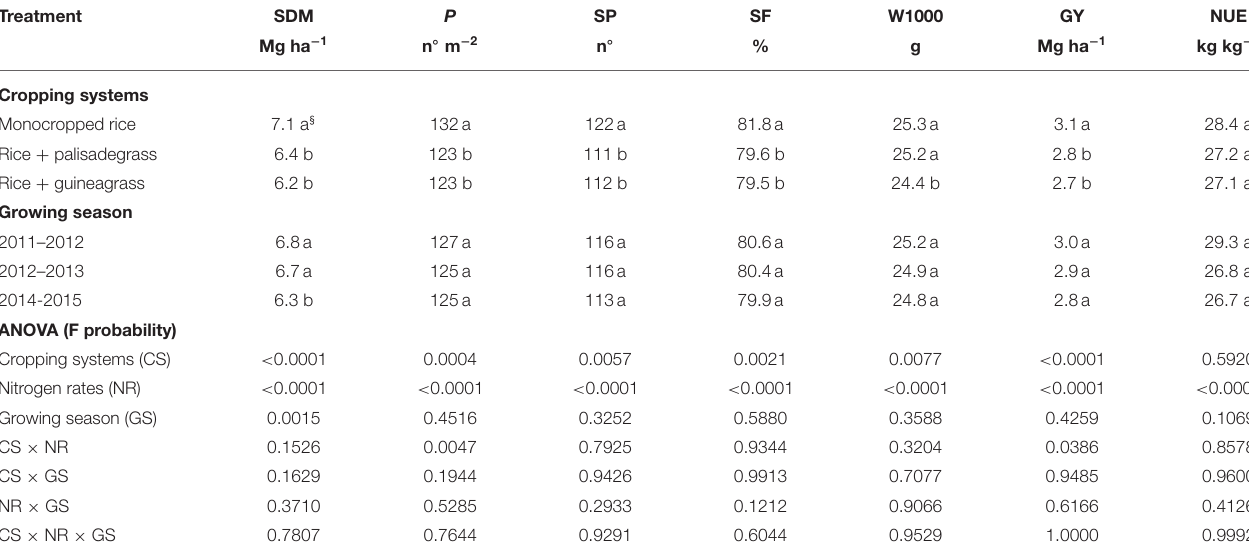
TABLE 1 | Shoot dry matter (SDM), panicles per m 2 (P), spikelets per panicle (SP), spikelet fertility (SF), 1,000-grain weight (W1000), grain yield (GY), and N-use efficiency (NUE) of upland rice as affected by cropping systems, sidedress nitrogen rates, and growing season. Treatment